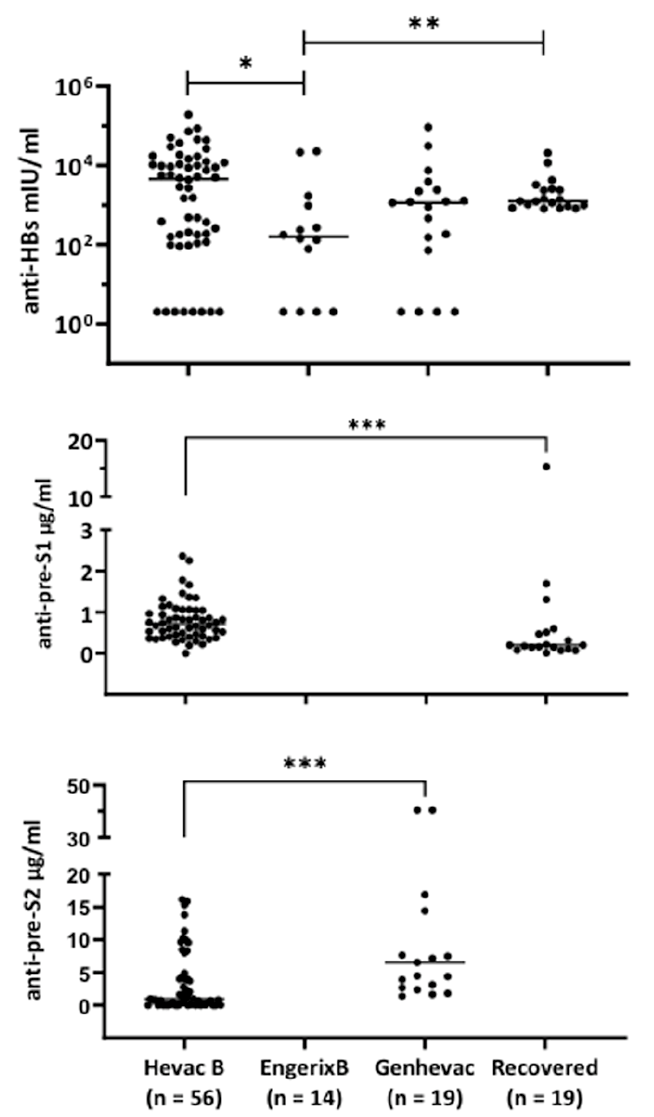
Figure 1. Anti-HBs, anti-preS1, and anti-preS2 antibodies’ detection in the plasma of individuals vaccinate with Hevac-B, Engerix-B, and Genhevac-B vaccines or after recovery from acute infection. Each dot corresponds to an individual subject. Anti-preS1 and anti-preS2 ELISA titers are expressed in equivalent of µ g/mL of R271- or R272-IgG positive controls, respectively. * p -value < 0.05, **, p -value < 0.01, ***, p -value < 0.001.